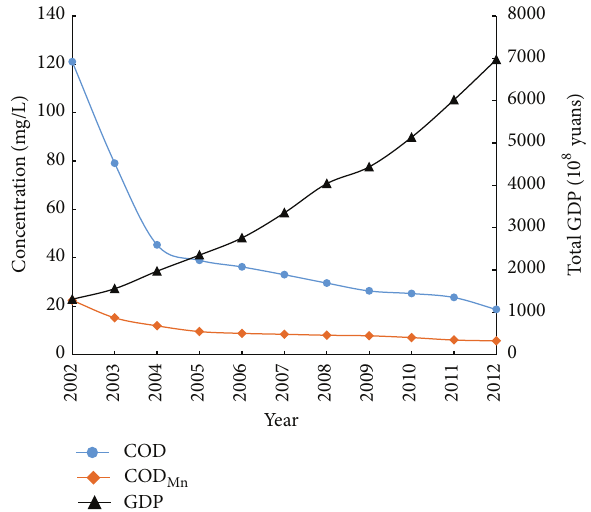
Figure 4: The variation trends of water quality with GDP growth in the Nansi Lake Basin during 2002 ∼